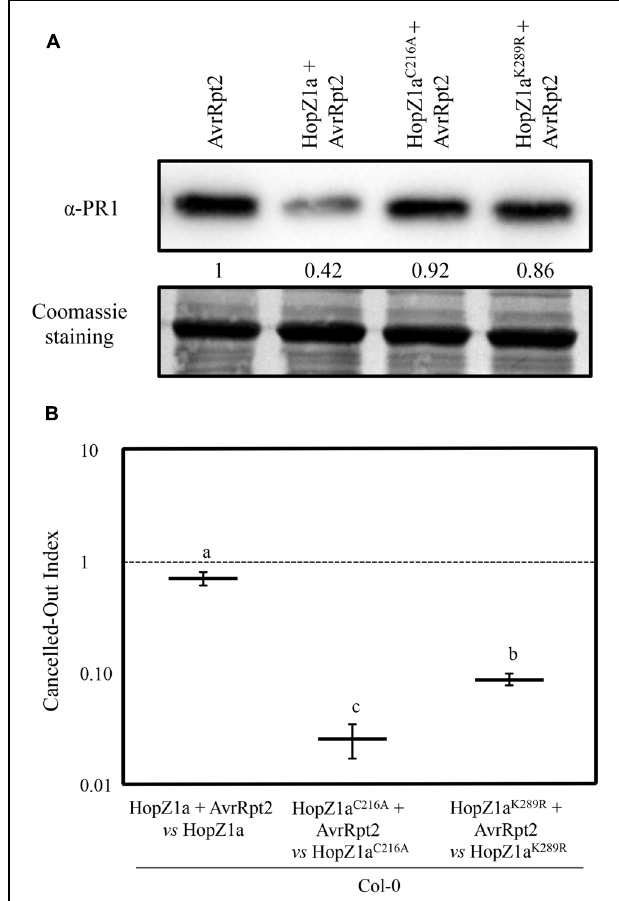
FIGURE 2 | HopZ1a K289R partially suppresses AvrRpt2-triggered immunity. (A) Western blot showing PR1 accumulation in Col-0 leaves inoculated with 5 × 10 5 cfu/ml of DC3000 expressing AvrRpt2 (pAME8) alone or co-expressing AvrRpt2 with HopZ1a (pAME33), HopZ1a C216A (pAME34), or HopZ1a K289R (pJRU10). Ten micrograms of total protein were loaded per sample, and Coomassie staining is shown as loading control. The signal intensity for each band was quantified using Fiji distribution of ImageJ software and is shown below the blot. The experiment was repeated twice with similar results. (B) Canceled-out indices (COIs) measuring growth within a mixed infection of DC3000 co-expressing AvrRpt2 and any of the three HopZ1a variants: wild-type HopZ1a (pAME33), HopZ1a C216A (pAME34) or HopZ1a K289R (pJRU10), in relation to growth of DC3000 expressing only the corresponding HopZ1a: wild-type HopZ1a (pAME30Gm), HopZ1a C216A (pAME27Gm), or HopZ1a K289R (pMAM1Gm). COIs are calculated as the output ratio between the strain expressing both effectors and the strain expressing just one, divided by their input ratio. Each COI value represents the means of two independent experiments with three biological replicates each. Error bars represent the standard error. Mean values marked with the same letter are not significantly different from each other as established by Student’s t -test ( P <